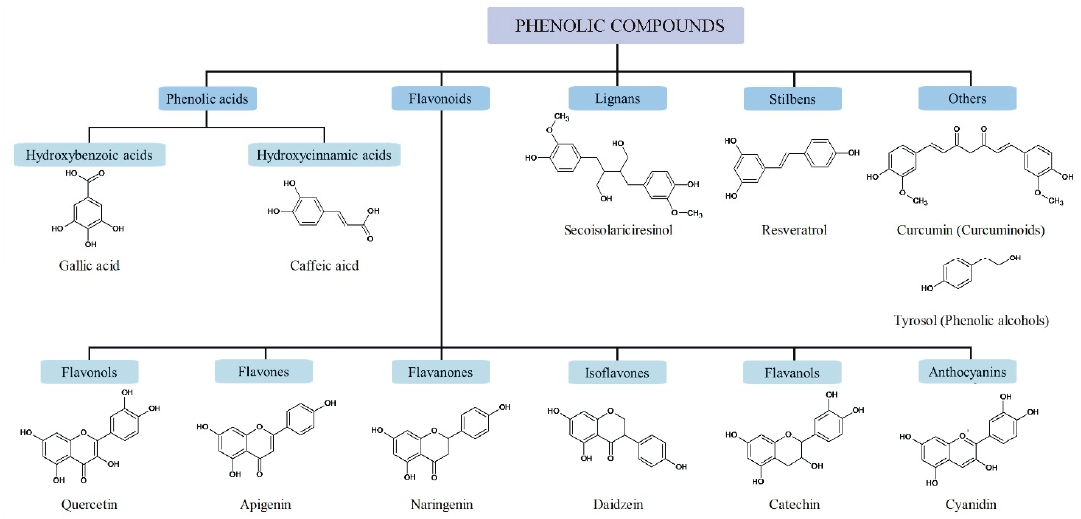
Figure 1. Classification and structure of the cited phenolic families.